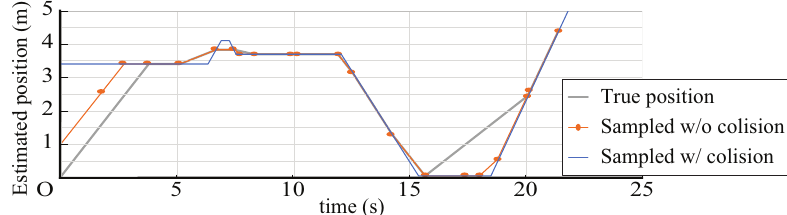
Figure 13. Example of estimated flow lines including